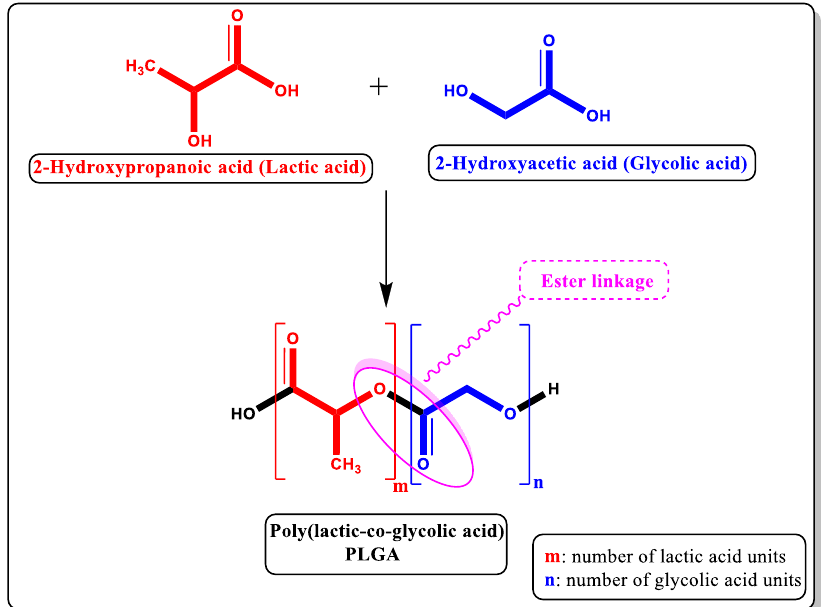
Figure 1. Schematic representation of chemical structure for PLGA and its monomers. Due to the presence of ester linkages that are degraded by hydrolysis in aqueous environments.